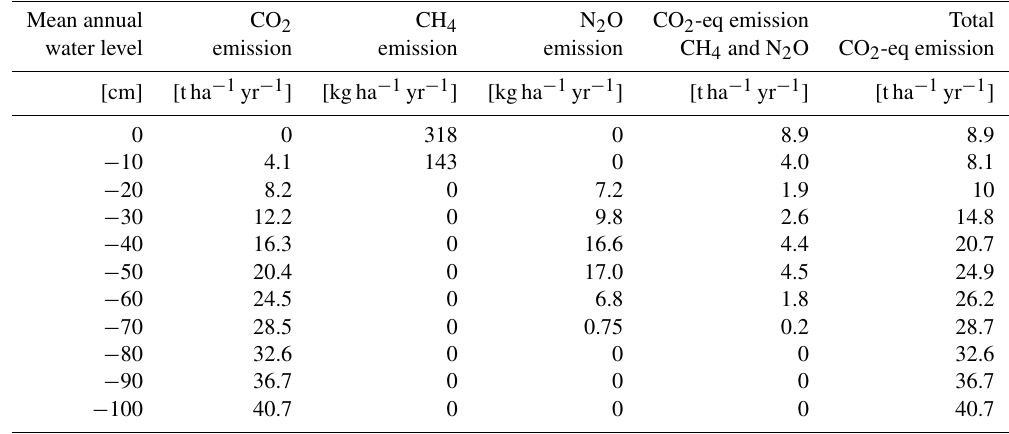
Table 1. Methods used to calculate GHG emissions due to soil subsidence. No. Table 2. Emissions of CO 2 , CH 4 and N 2 O (derived from Jurasinski et al.,